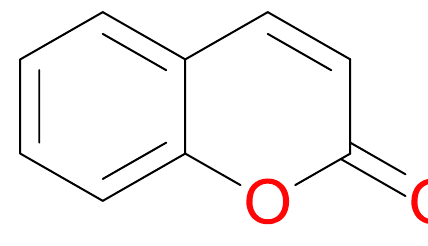
Figure 17. Coumarin structure.